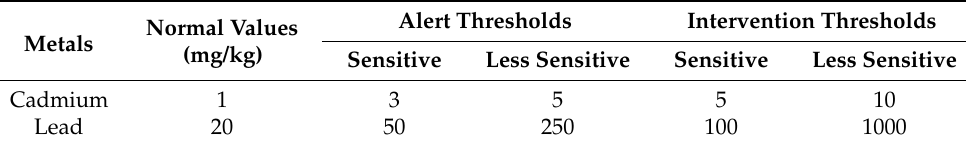
Table 1. Benchmarks for traces of chemical elements in the soil